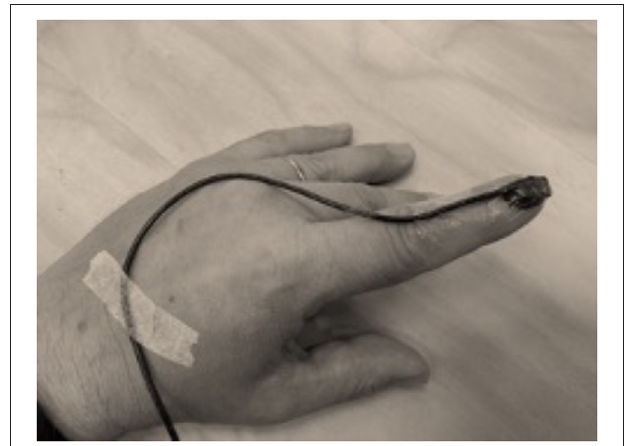
FIGURE 3 | A typical setting in corticokinematic coherence studies (42–44) with a lightweight accelerometer (ADXL335; Analog Devices Inc, Norwood, MA) attached on the finger nail to pick up hand movements. Note that flexible cable allows natural hand movements.